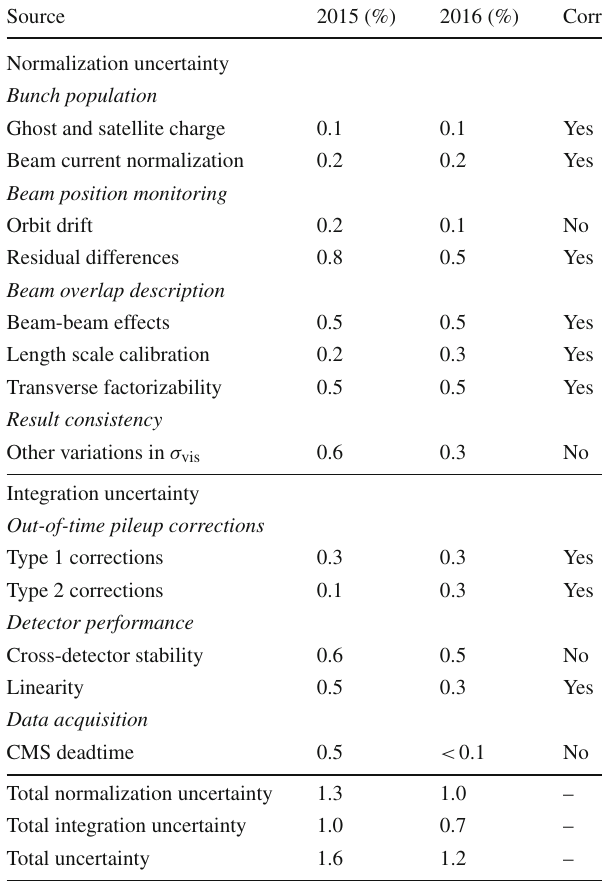
Table 4 Summary of contributions to the relative systematic uncer- √ s = 13TeV in 2015 and 2016. The systematic tainty in σ vis (in %) at uncertainty is divided into groups affecting the description of the vdM profile and the bunch population product measurement (normalization), and the measurement of the rate in physics running conditions (integra- tion). The fourth column indicates whether the sources of uncertainty √ s = are correlated between the two calibrations at